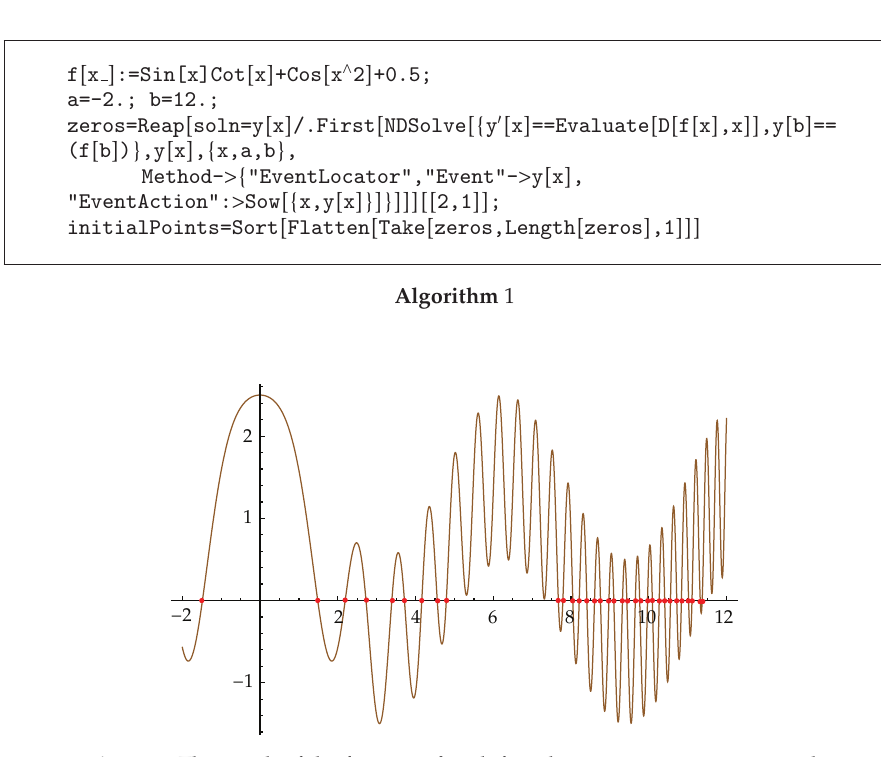
Figure 1: The graph of the function f with finitely many zeros in an